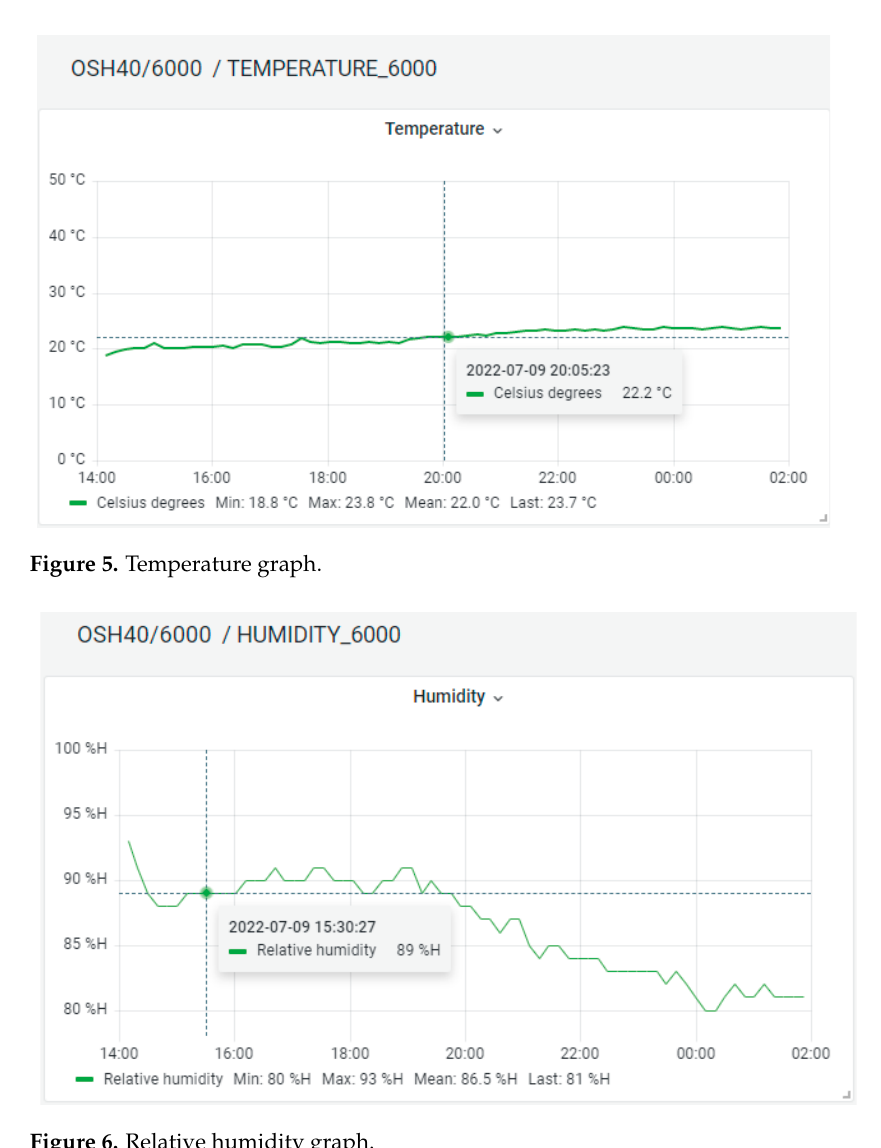
Figure 6. Relative humidity graph.